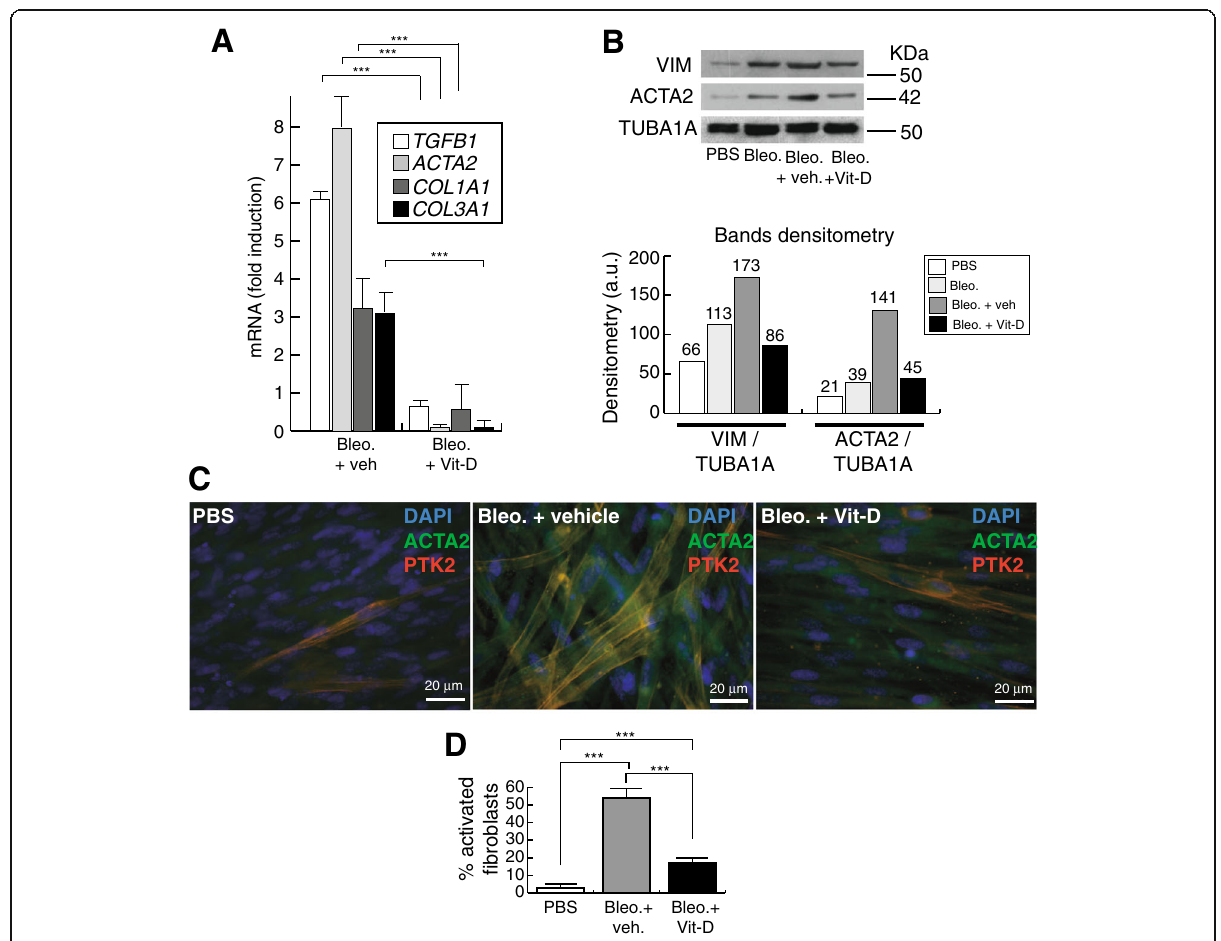
Fig. 4 Effect of vitamin D on the fibrogenic activation of myofibroblasts. a RT-qPCR result: expression of a representative profibrogenic cluster of genes. Cells were pretreated with 5 nmol/L vitamin D for 2 h, subjected to a bleomycin shock (12 μ g/mL for 6 h) and then treated with 5 nmol/L vitamin D or its vehicle. Analysis was performed 72h post-shock. Values are folds of induction over control cultures (treated with bleomycin vehicle: PBS); veh.: vitamin D vehicle. The results presented in the figures are means ± SEM. Significance of the analysis is indicated as ***, P <0.001. b Detection of VIM (vimentin) and ACTA2 ( α -SMA) in myofibroblasts cell extracts. Cells were pretreated with 5nmol/L vitamin D for 2h, subjected to a bleomycin shock (12 μ g/mL for 6h) and then treated with 5nmol/L vitamin D or its vehicle. Cell extracts were obtained at 72h post-shock. PBS is the bleomycin vehicle; veh.: vitamin D vehicle. TUBA1A (tubulin α ) was used as loading control. KDa: kilodaltons. Bottom panel: densitometry analysis of bands; a.u.: